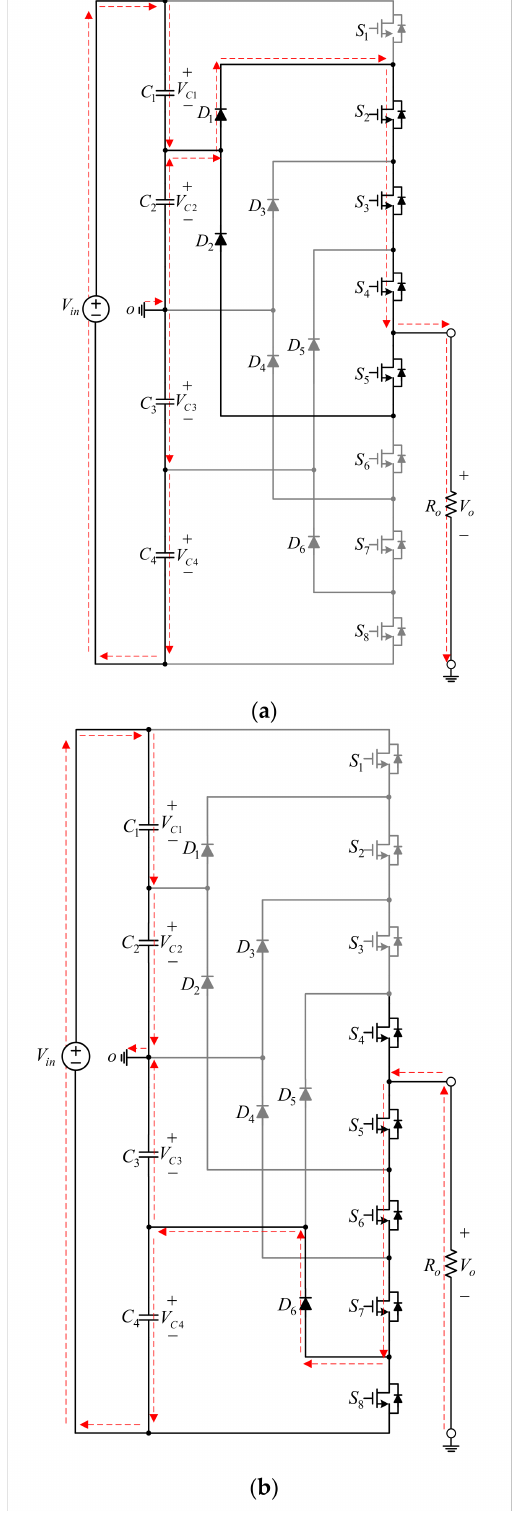
Figure 5. ( a ) Current flow direction of 0.25 V in output voltage; ( b ) current flow direction of − 0.25 V in voltage